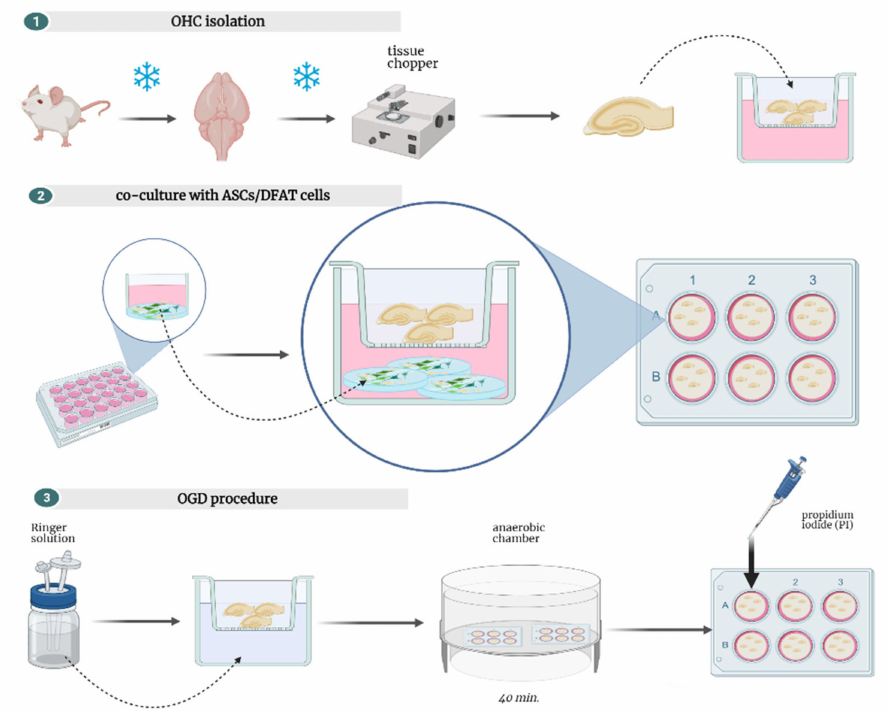
Figure 4. Steps of performed ex vivo experiments. The scheme was made in Biorender (https: //biorender.com/, accessed date: 10 January